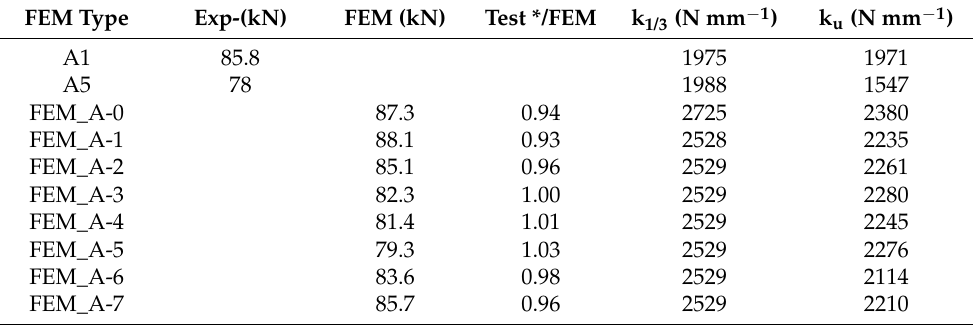
Table 5. Comparison of the test results with FEM predictions with different grain deviation angles for unreinforced timber